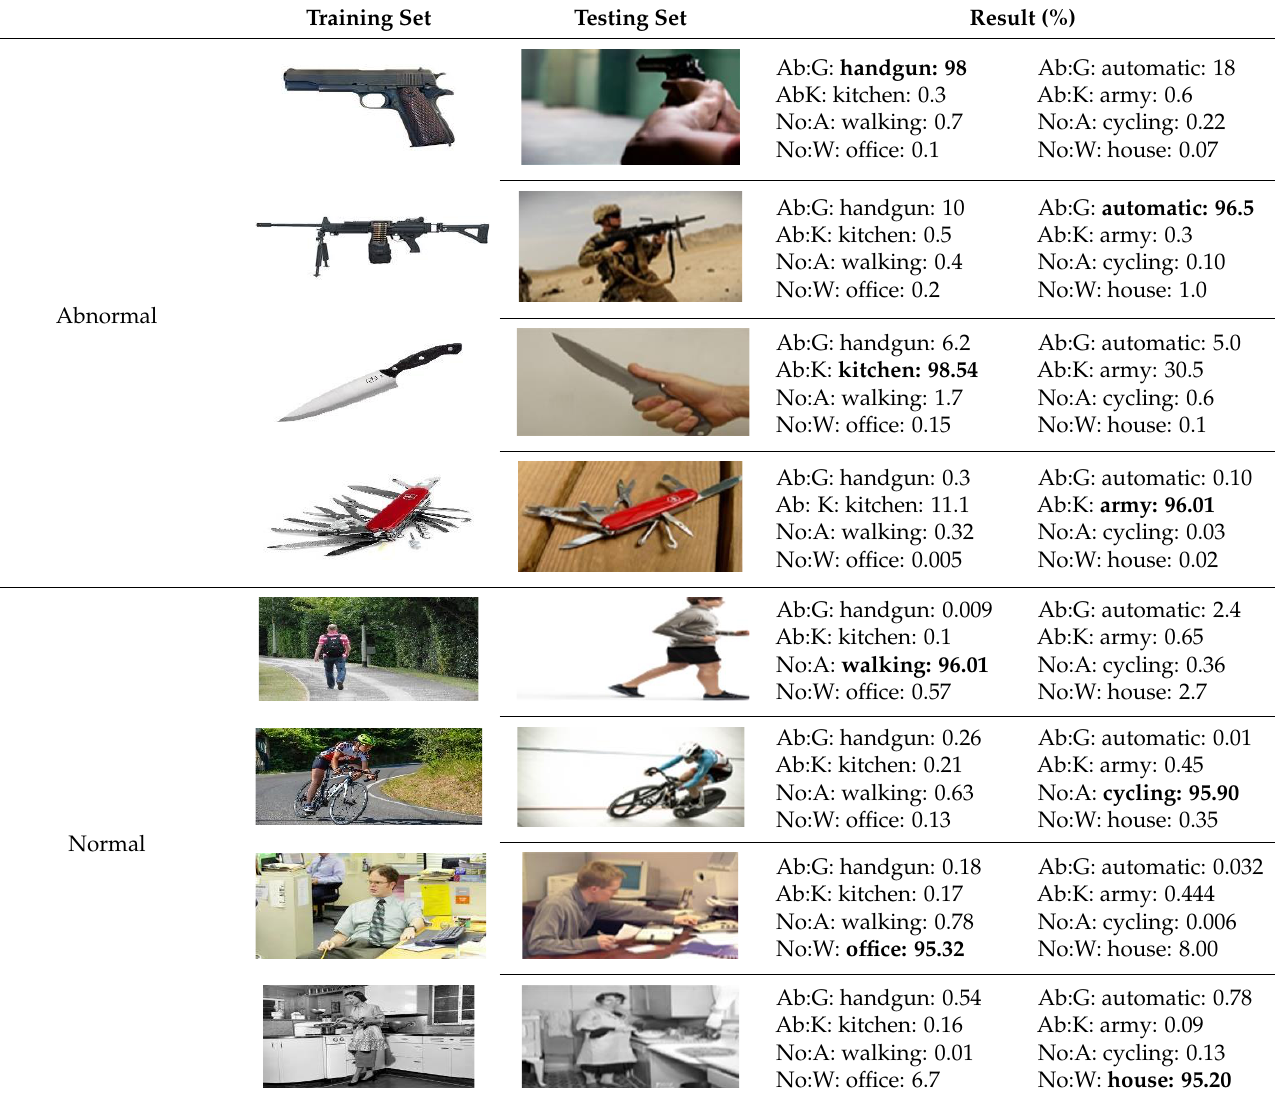
Table 5. The confidence score for each subclass. Training Set Testing Set